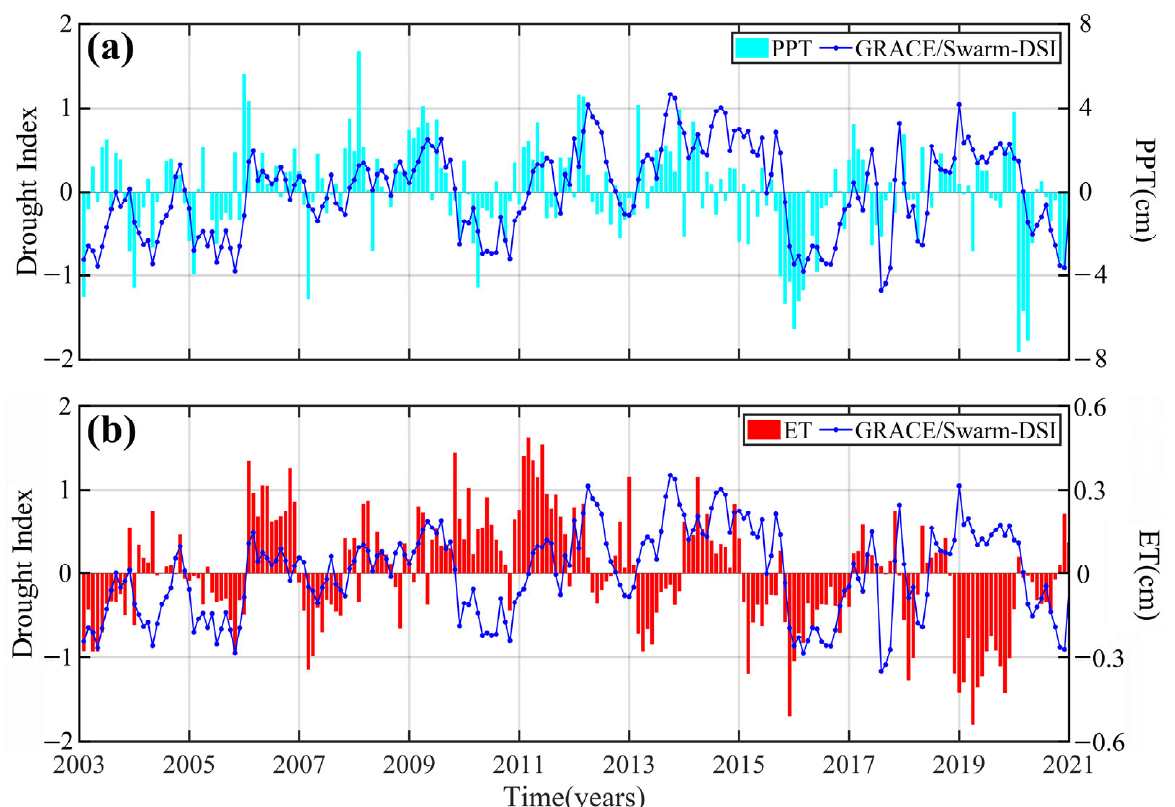
Figure 11. The series time of monthly GRACE/Swarm-DSI, PPT anomaly ( a ) and ET anomaly ( b ) in ARB during 2003–2020.